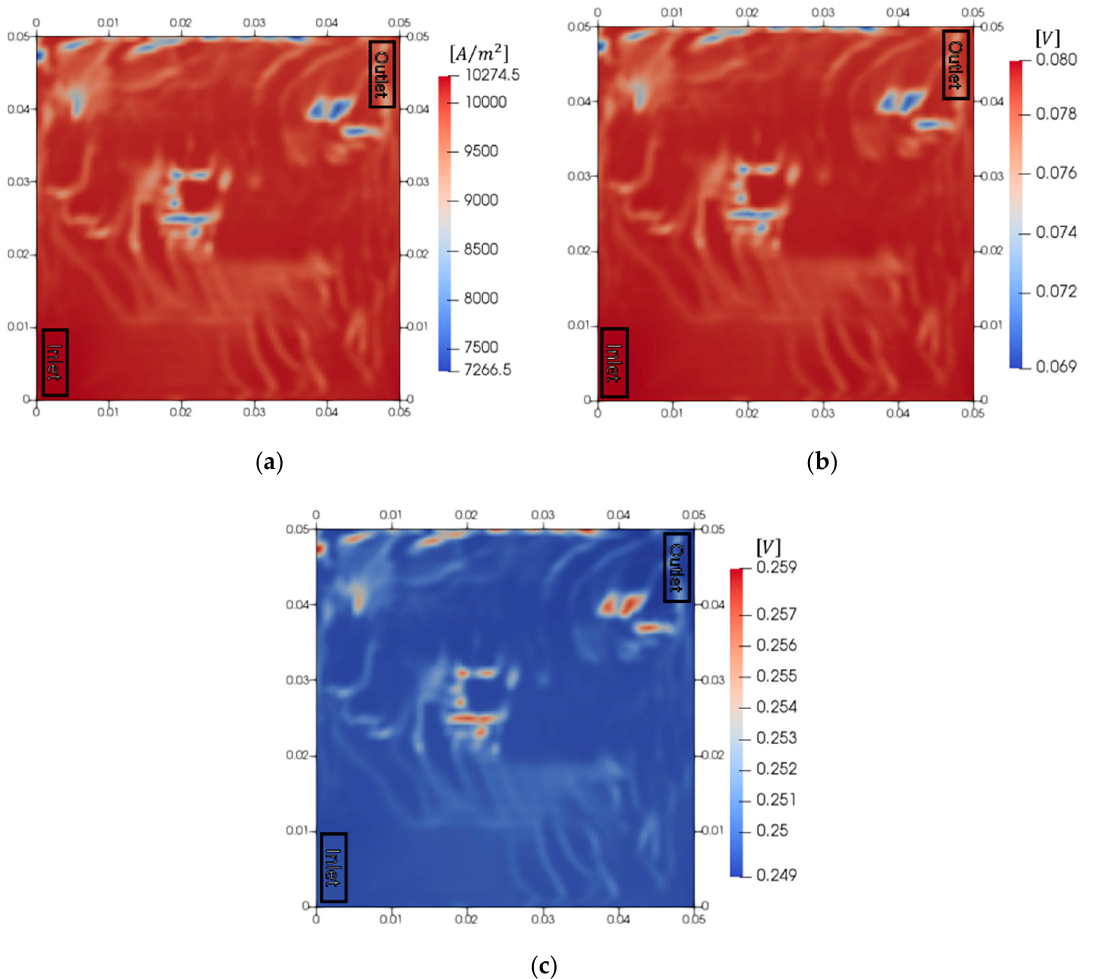
Figure 4. Electrochemical behaviors in PEMWE at a current density of 10,000 A/m 2 (time=1 s). ( a ) Current density, ( b ) overpotential of cathode reaction and ( c ) overpotential of anode reaction. The decrease in performance was determined by the amounts of oxygen bubbles and the reactant.